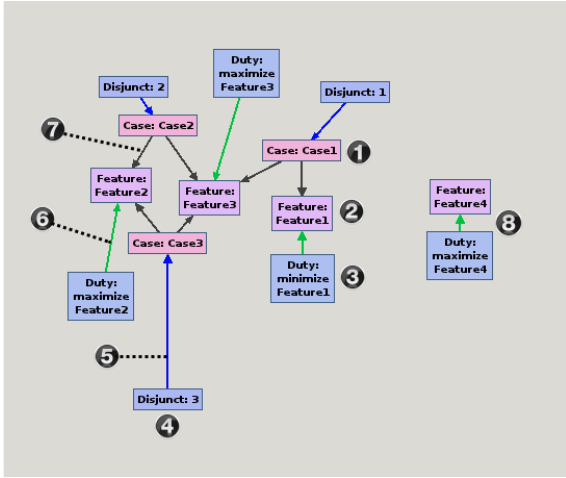
Figure 5: Graph features showing samples of how related data is displayed including 1) a case, 2) relevant feature, 3) corresponding duty, and 4) covering disjunct.